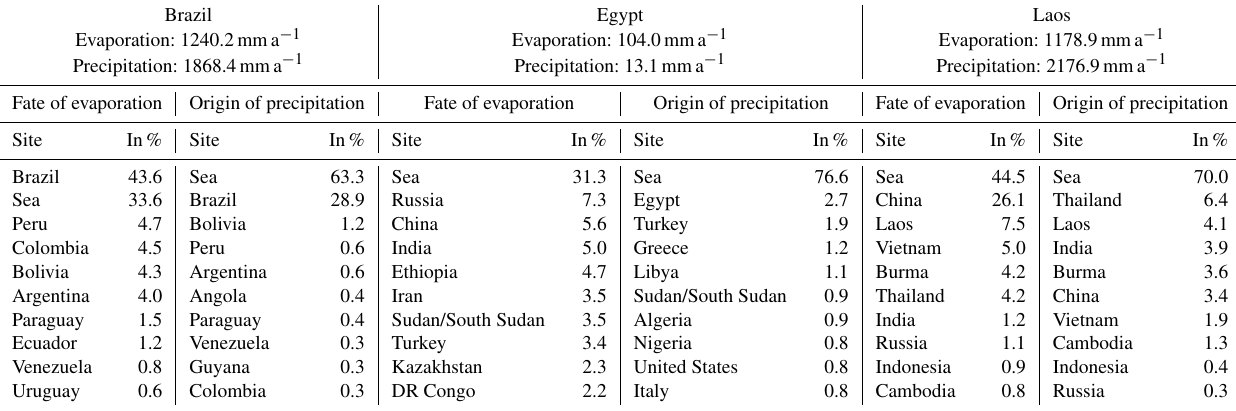
Table 3. Fate of evaporation and source of precipitation: examples for country tables. Brazil